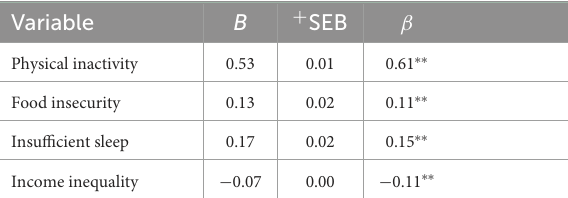
TABLE 1 Regression analysis summary for variables predicting obesity.